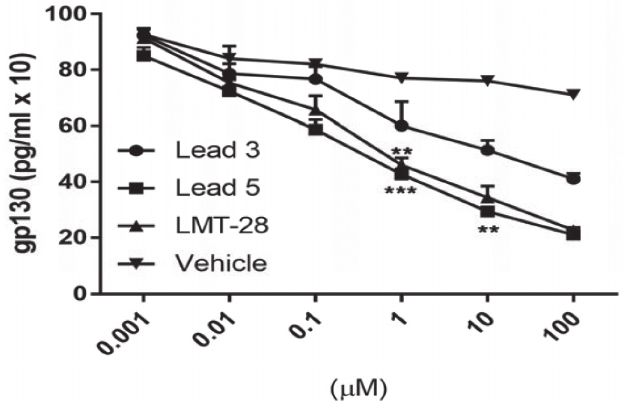
FIGURE 5 - Effect of top two lead compounds on gp130 dimerization in macrophages. Cells treated with indicated concentrations of these two compounds LMT-28 or left untreated. The culture supernatants were then removed and assayed for gp130 by ELISA. Data represented as mean ±SD of results obtained from at least three independent